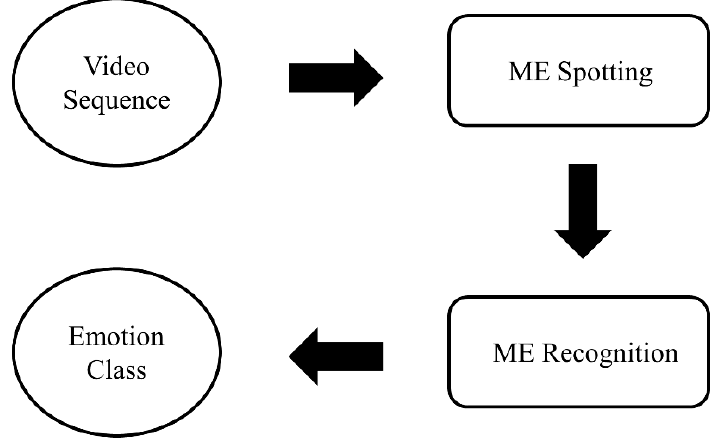
Figure 2. General flow of an automated micro expression analysis system.